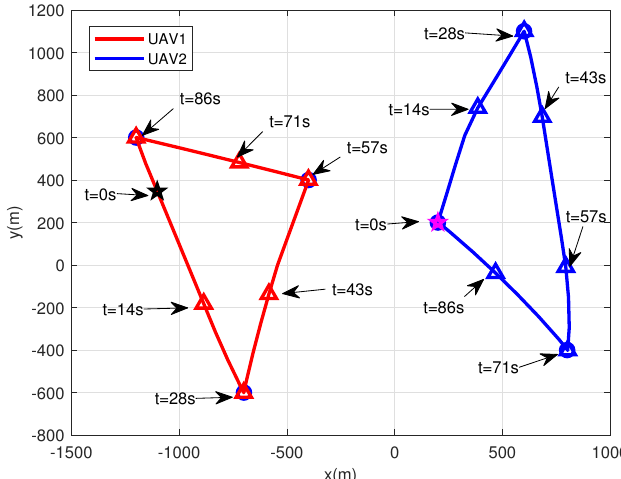
Figure 5. The real − time trajectories of two UAVs for the flight duration T = 100